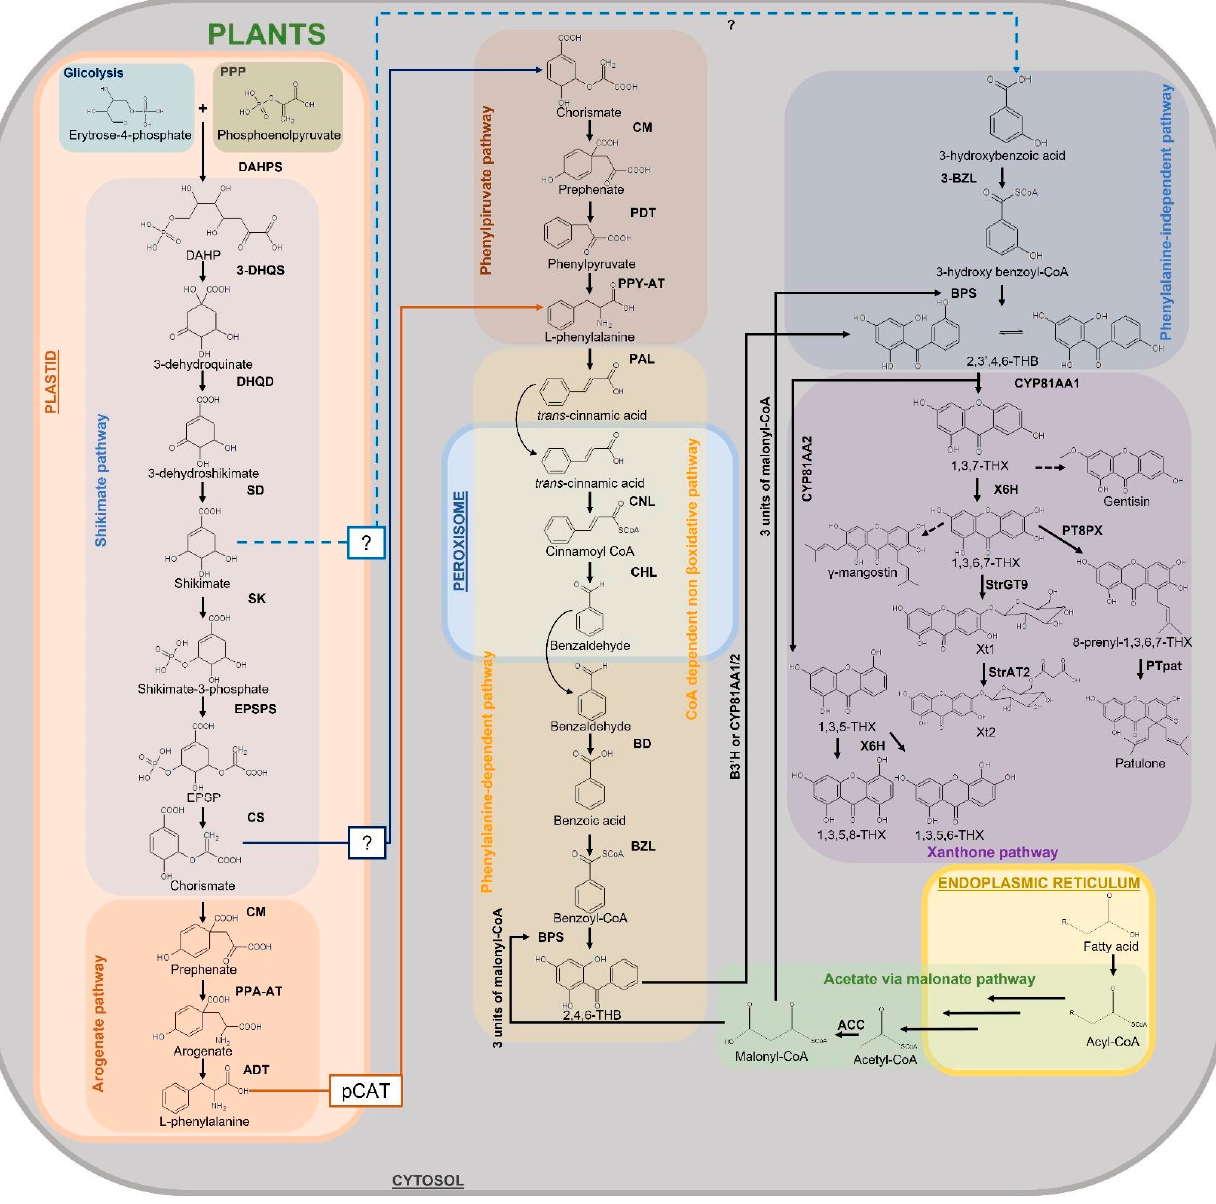
Figure 8. Pathways involved in xanthone biosynthesis in plants. ?: unknown proteins; 1,3,5,6-THX: